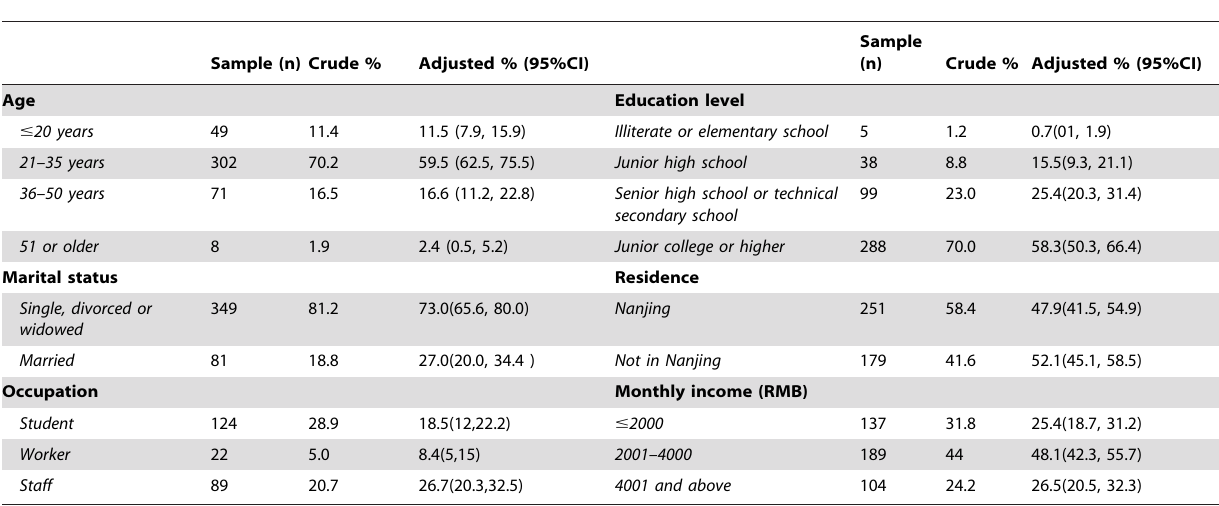
Table 1. Demographic characteristics of MSM at baseline in Nanjing, China, 2008 (n=430).